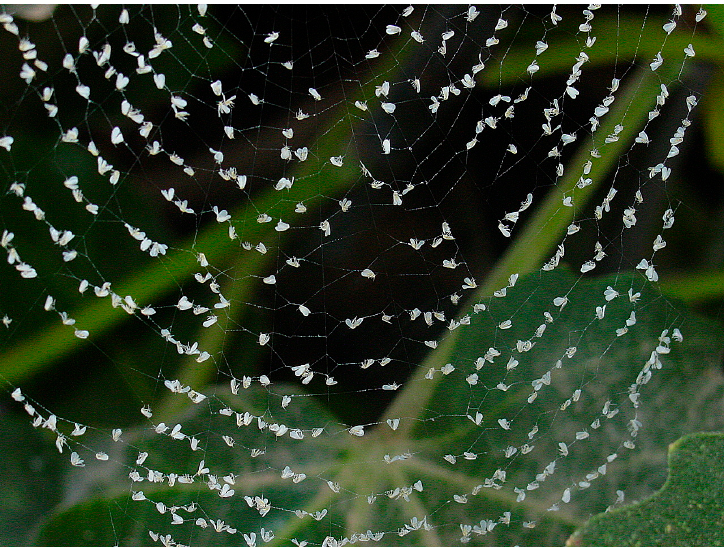
Figure 3. Example of B. tabaci adults trapped in webs built by web-weavers from crops surrounding greenhouses in the study area (Almeria, SE Spain). Photo: Jan van der Blom. Month of sampling was such a highly significant variable in arthropod populations.